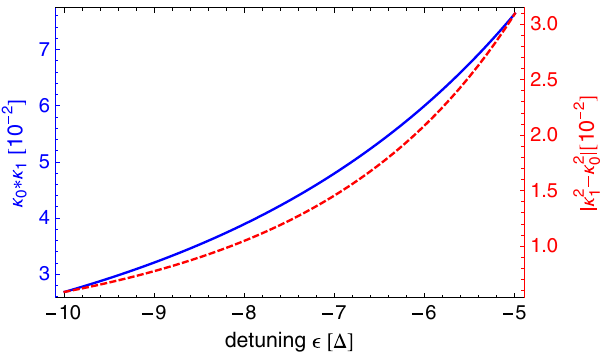
FIG. 11. The product κ 0 κ 1 directly affects the effective single- =g 0 ¼ κ 0 κ 1 [69], while the difference phonon Rabi frequency g QD j κ 2 1 − κ 2 0 j determines the robustness of the qubit against charge 5 Δ . noise. Here, t c ¼